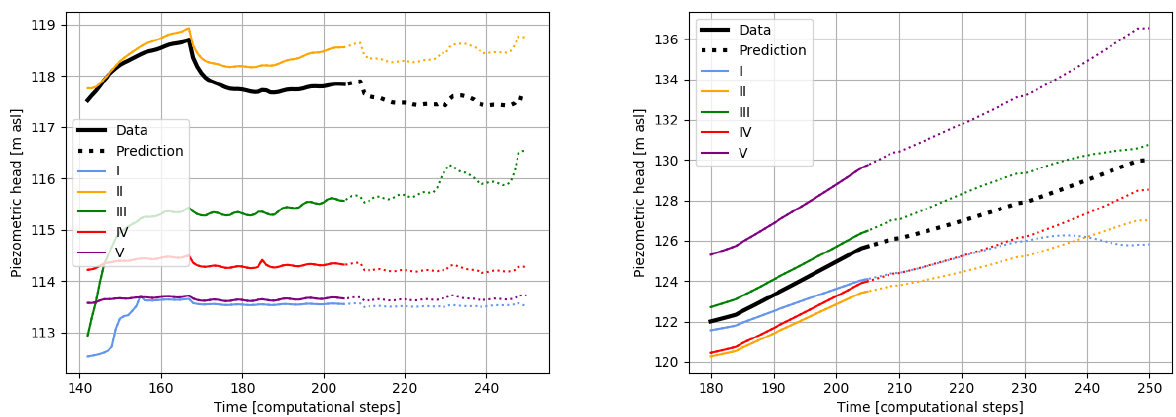
Figure 25: Prediction of piezometric head in piezometer P3 (left) and P4